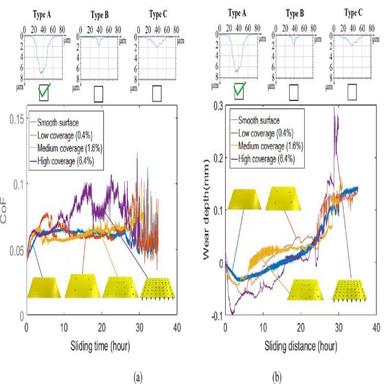
Measurement of (a) friction coefficient and (b) wear progression for different coverages of Type A (wide & deep) dimples.